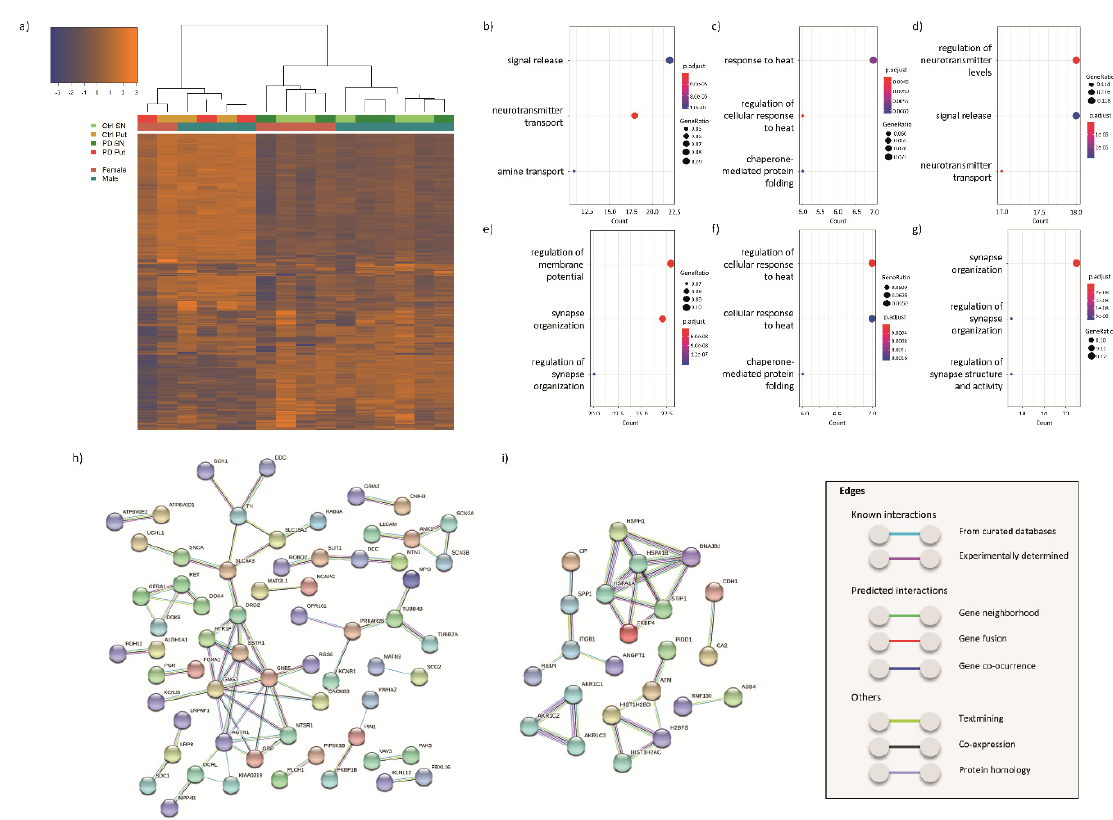
Figure 2. Transcriptomic analysis of the SN and putamen from PD patients compared to controls. ( a ) Hierarchical clustering of the samples based on the transcriptomic results; biological pathways enriched in ( b ) all, ( c ) upregulated and ( d ) downregulated DEGs found in our RNA-seq analysis of SN and in ( e ) all, ( f ) upregulated and ( g ) downregulated DEGs from the overlap between previous microarray mRNA expression profiling studies on SN from PD patients and controls (GSE7621, GSE42966, GSE49036, GSE20164, GSE20163, GSE20333 and GSE54282), including also the present study; interaction networks of proteins encoded by genes ( h ) downregulated or ( i ) upregulated in at least two of the eight studies included in the overlap analysis. Protein–protein networks were obtained with STRING [31]. Only the highest confidence associations were included. Non-connecting nodes were removed.